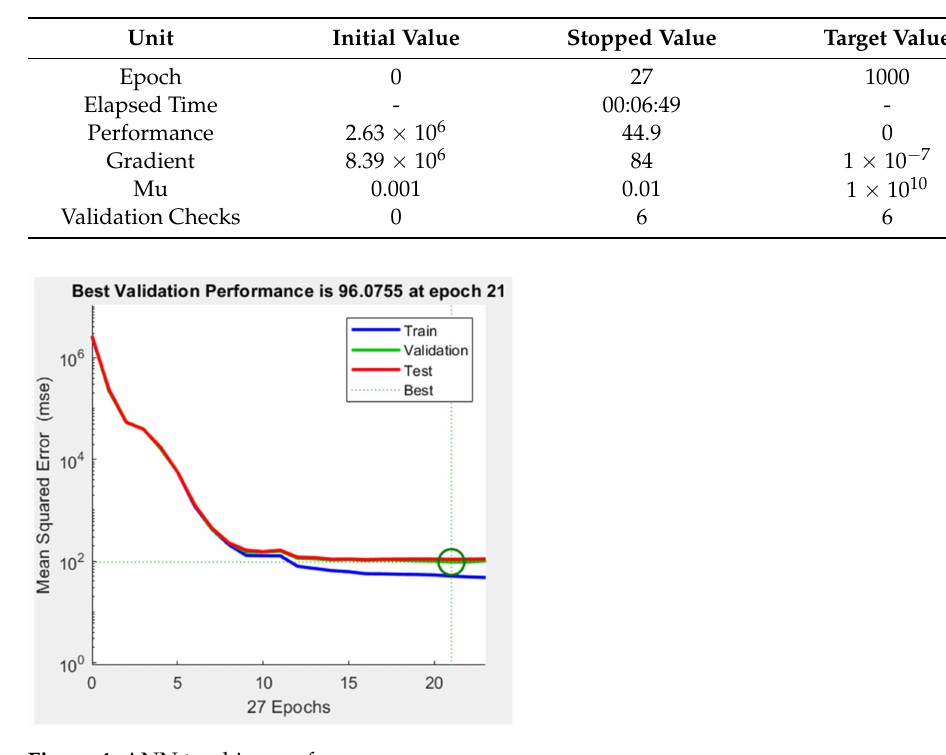
Table 4. Network training conditions.